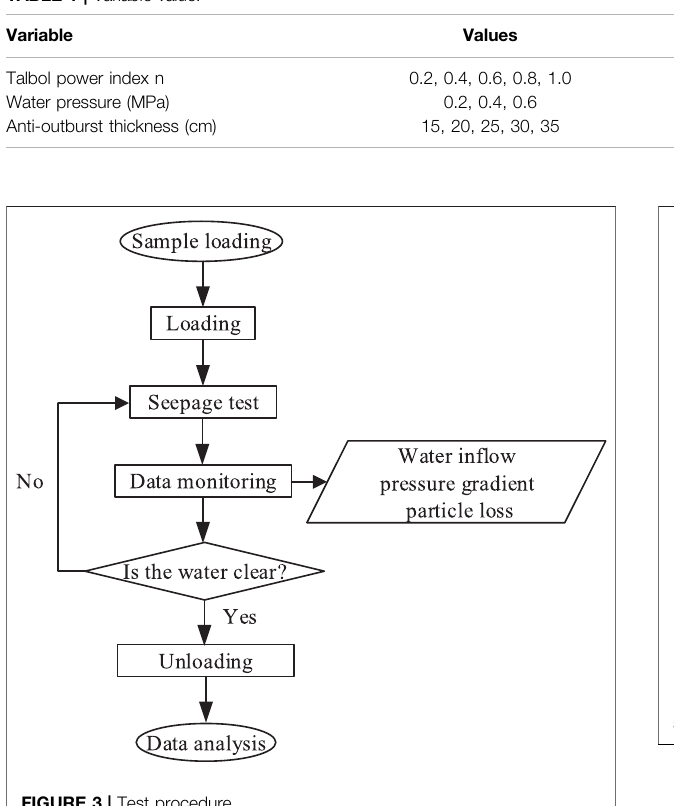
TABLE 1 | Variable value.